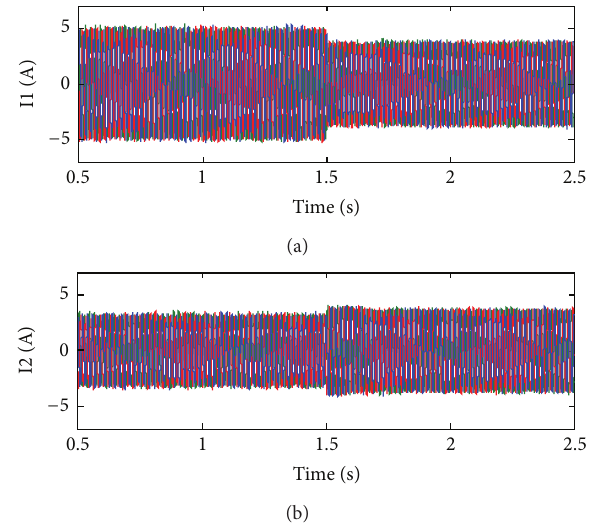
Figure 11: Simulation results of current sharing with conventional and proposed control. (a) Inverter 1. (b) Inverter